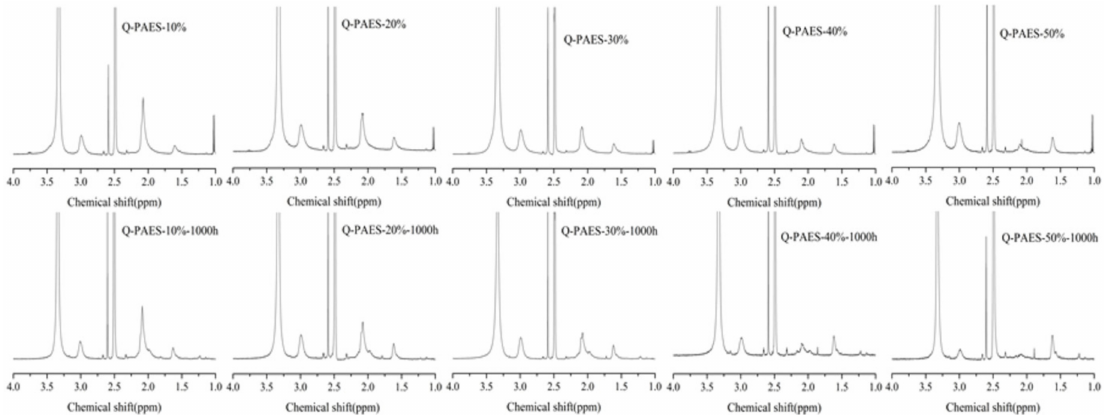
Figure 9. 1 H-NMR data of Q-PAES membranes before and after alkaline stability operation in 1 M KOH solution at 70 ◦ C for 1000